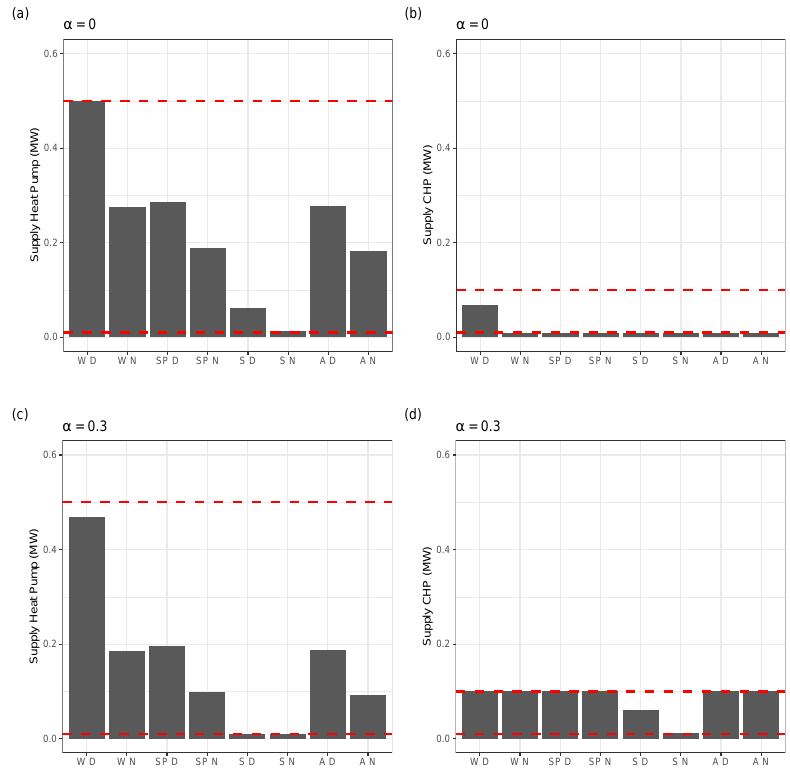
Figure 2. Units of end-user heat demand supplied by the data centre ( a , c ) and the CHP ( b , d ) in each time segment for α = 0.3 (upper panels) and α = 0 (lower panels). Red dashed lines denote the capacity constraints of each technology.